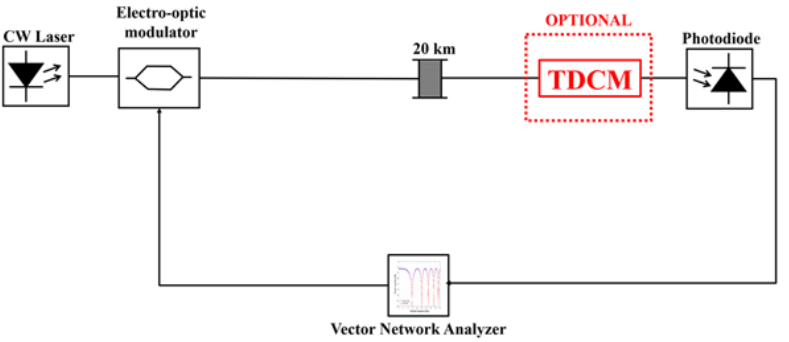
Figure 11. Experimental setup for dispersion penalty measurements with and without tunable dispersion-compensation module (TDCM). dispersion-compensation module (TDCM).